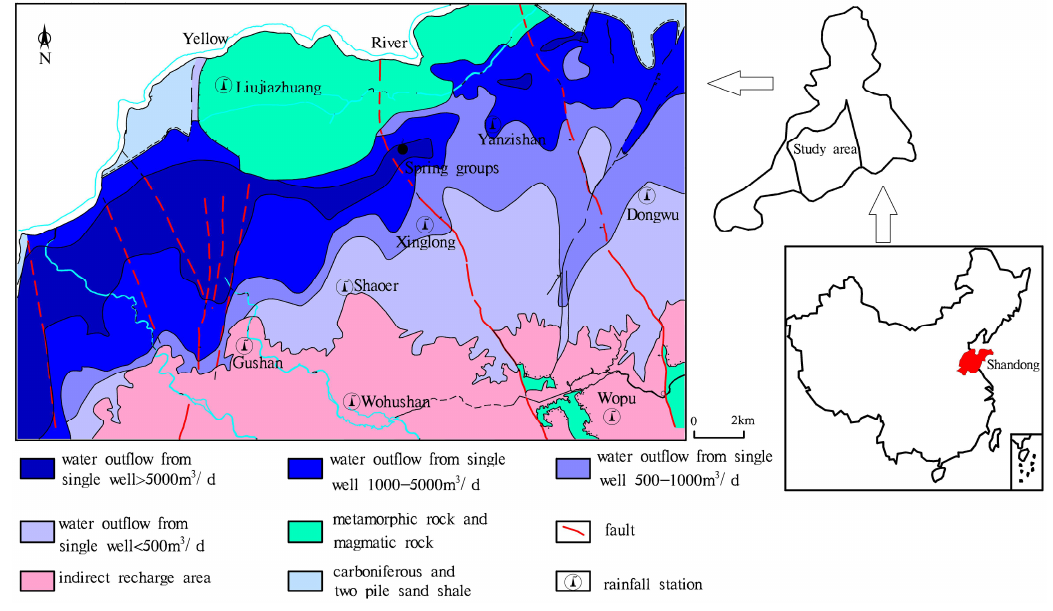
Figure 1. Hydrographic map of the Jinan spring area.